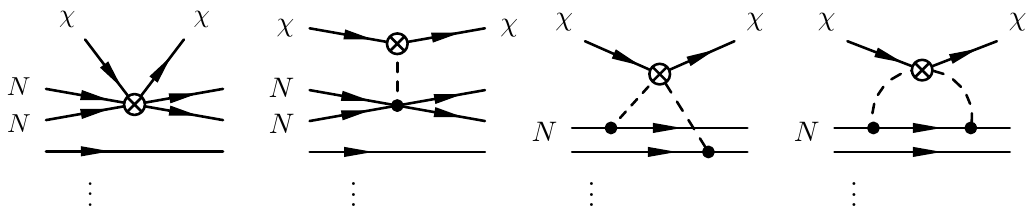
Figure 3: Sample NLO diagrams for the DM-nucleon scattering inside nuclei. The effective DM–nucleon or DM–meson interaction is denoted by a box, the dashed lines denote